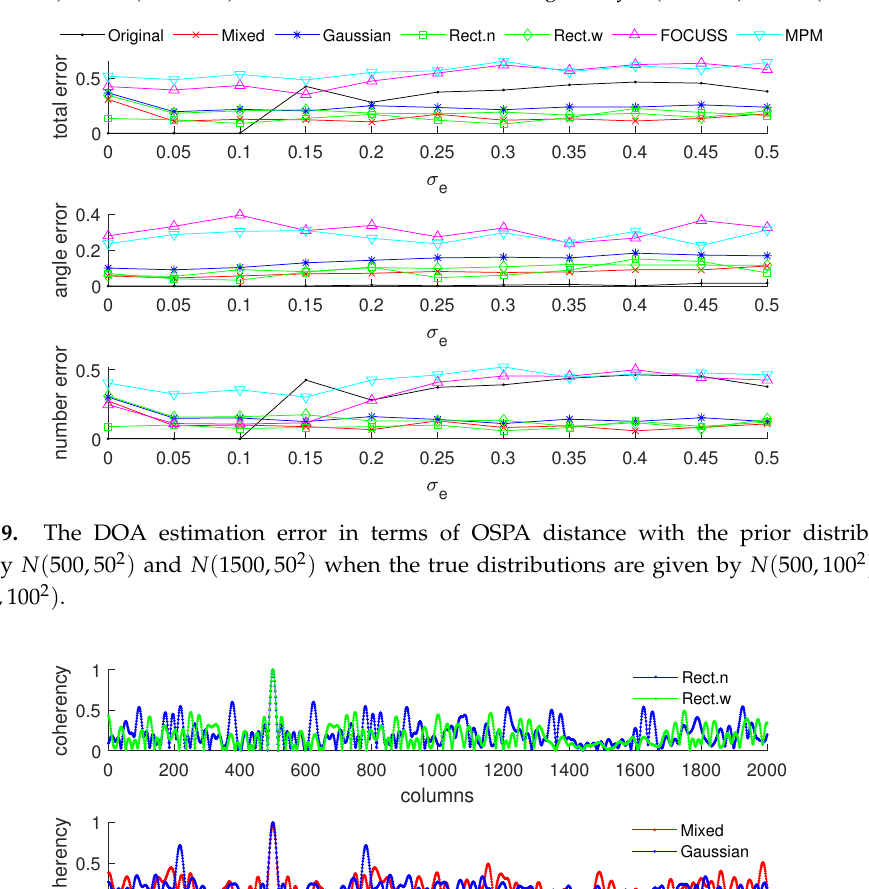
Figure 8. The DOA estimation error in terms of OSPA distance with the prior distribution given by N ( 500,50 2 ) and N ( 1500,50 2 ) when the true distributions are given by N ( 500,30 2 ) and N ( 1500,30 2 ) .